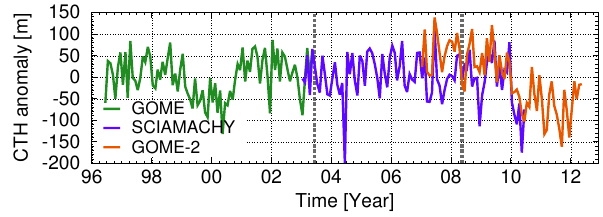
Figure 3. Monthly means of CTH anomaly. The dashed gray verti- cal lines show the months at which the time series have been merged (June 2003 and May